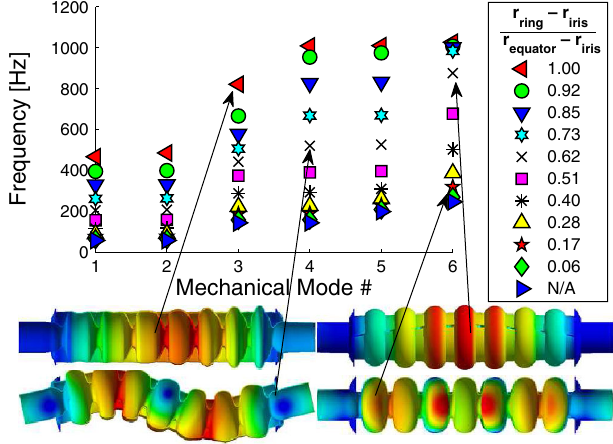
FIG. 16. Frequencies of the first 6 mechanical resonances of the 7-cell cavity for various stiffening ring